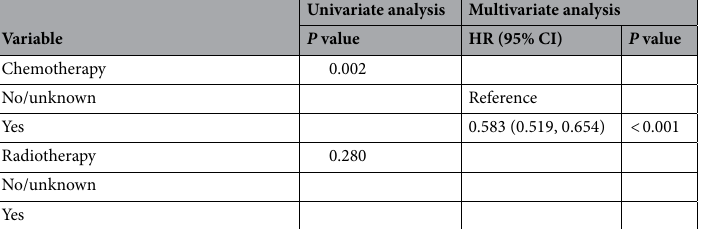
Table 2. Univariate and multivariate analyses of overall survival (OS) for patients in training set. NI not included in the multivariate survival analysis, a marital status was used as an adjusted factor in multivariate analysis.